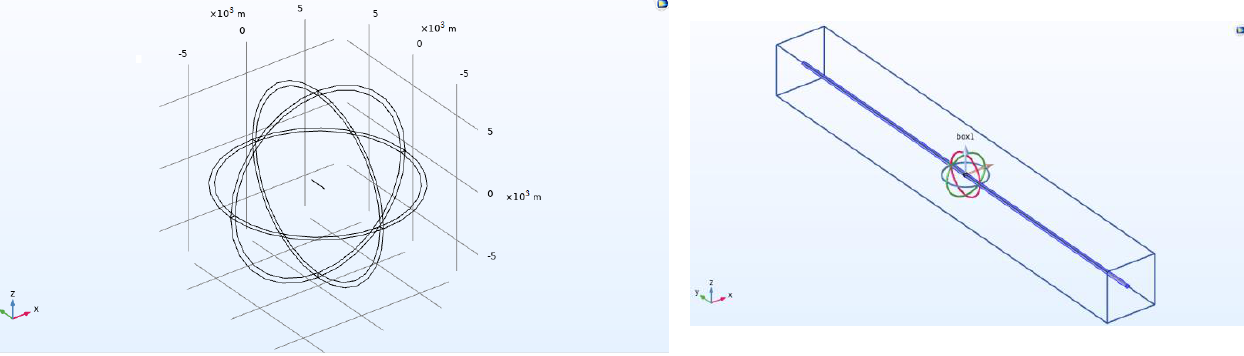
Figure 4. Structure of the dipole antenna.